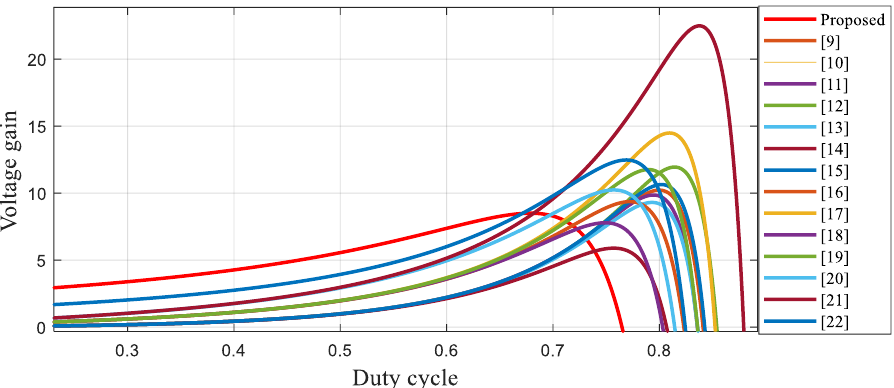
Figure 6. The comparison of the non-ideal voltage gain of the proposed converter with the mentioned converters of